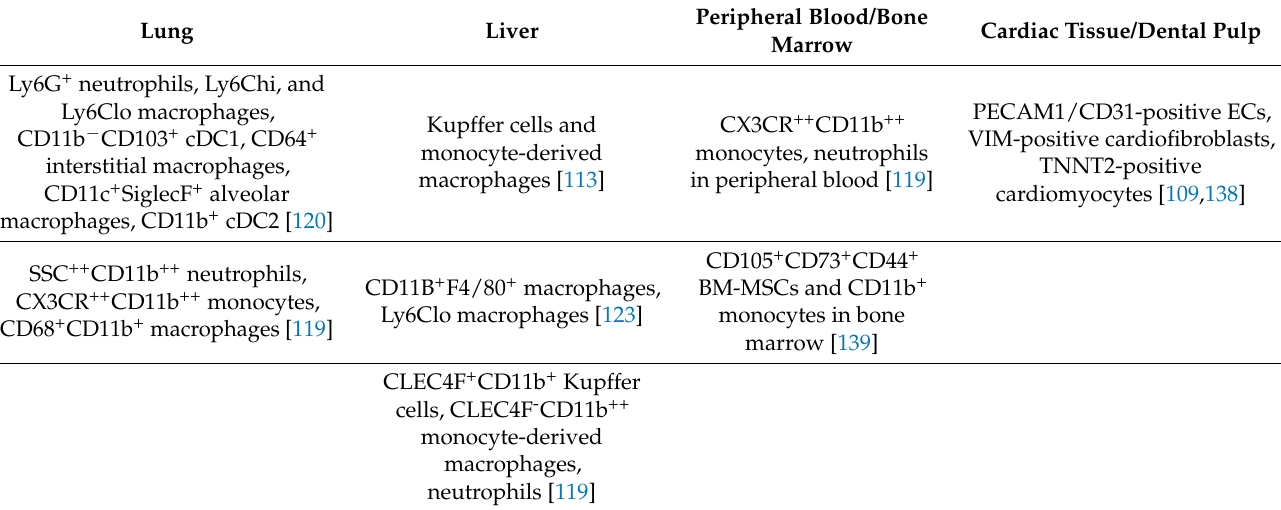
Table 2. Identified cell subpopulations capable of engulfing apoptotic MSCs or MSC-derived ApoBDs in